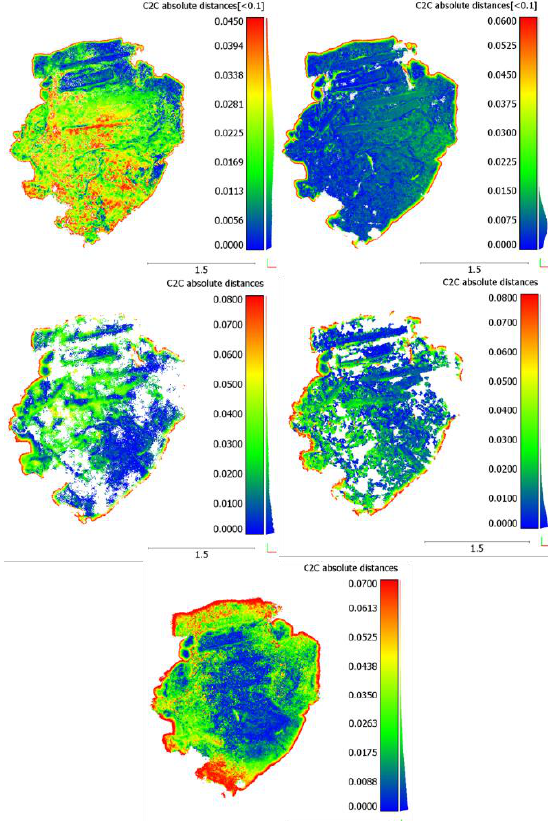
Table 1: Metrics of comparisons between the point clouds the 5 different packages produce